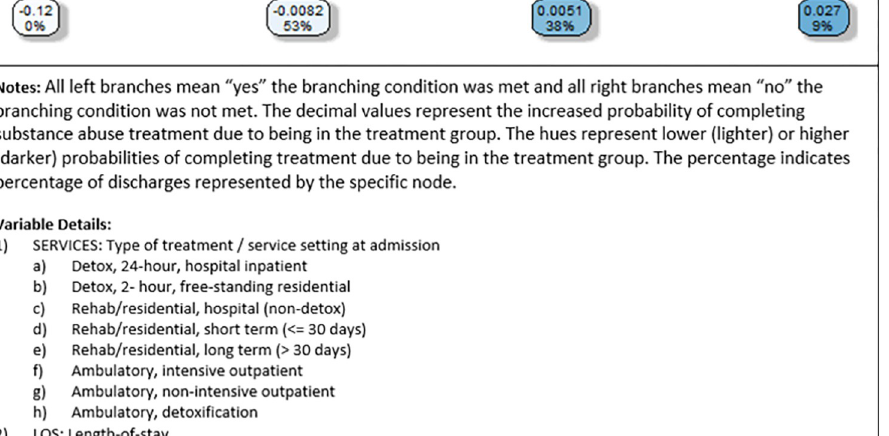
Fig 3 depicts the decision tree for income source disparity, where the probability difference was calculated as P (wages/salary)–P (all other income sources). The nodes represent the 1i 0i increased (or decreased) probability of completing treatment successfully when a regular source of job-related income is available. Overall, all the probabilities are positive, suggesting that those with job-related income are more likely to successfully complete treatment. Those who have not used in the past month (54% of the sample) have a 3.5% higher probability of completing treatment if their income source is from wages or salary. Further, one of the high- est probabilities is 4.3%, representing 28% of the sample, for those with no use in the past month and using either drugs only or drugs in addition to alcohol use. The other highest prob- ability is 4.2%, for those with no use in the past month, are only alcohol users, and who are either discharged from Detox 24-hour free-standing residential or any of the rehab/residential types of programs. We also note that these probabilities (4.3% and 4.2% respectively) are higher than the highest probability associated with racial disparities (2.7%), suggesting that